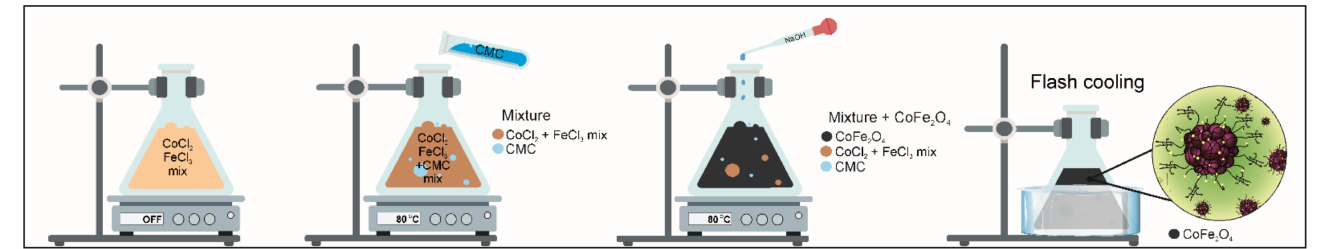
Scheme 1. Schematic representation of carboxymethyl cellulose embedded CoFe 2 O 4 magnetic